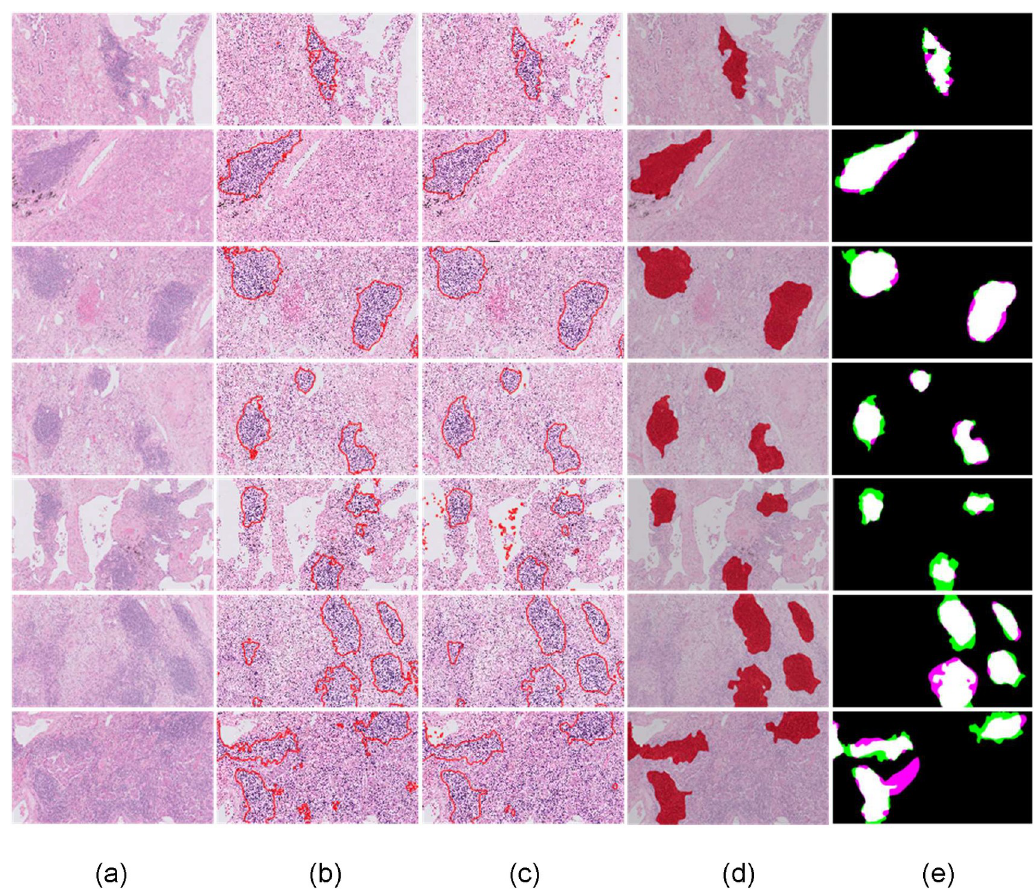
Fig 4. Identification of TLS regions and density of lymphocytes. a) input 10x H&E-stained image, b) DeepLabv3+ identified TLS regions, c) application of active contour model d) post validation of candidate TLS regions—detected TLS regions e) identified TLS regions (classification threshold at 0.5) in comparison with ground truth: White color (True Positive), green color (False Positive), magenta color (False Negative).